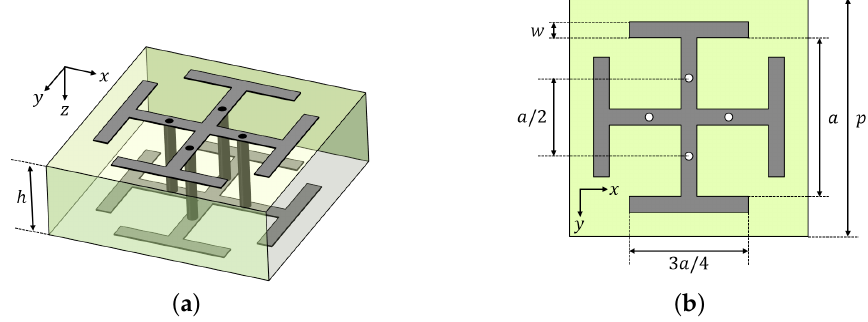
Figure 11. Unit cell of a single-layer isotropic metafilm with p = 3 mm, w = 0.2 mm, h = 1 mm, radius of vias equals 0.05 mm and relative permittivity ε r = 4: ( a ) perspective view, ( b ) top